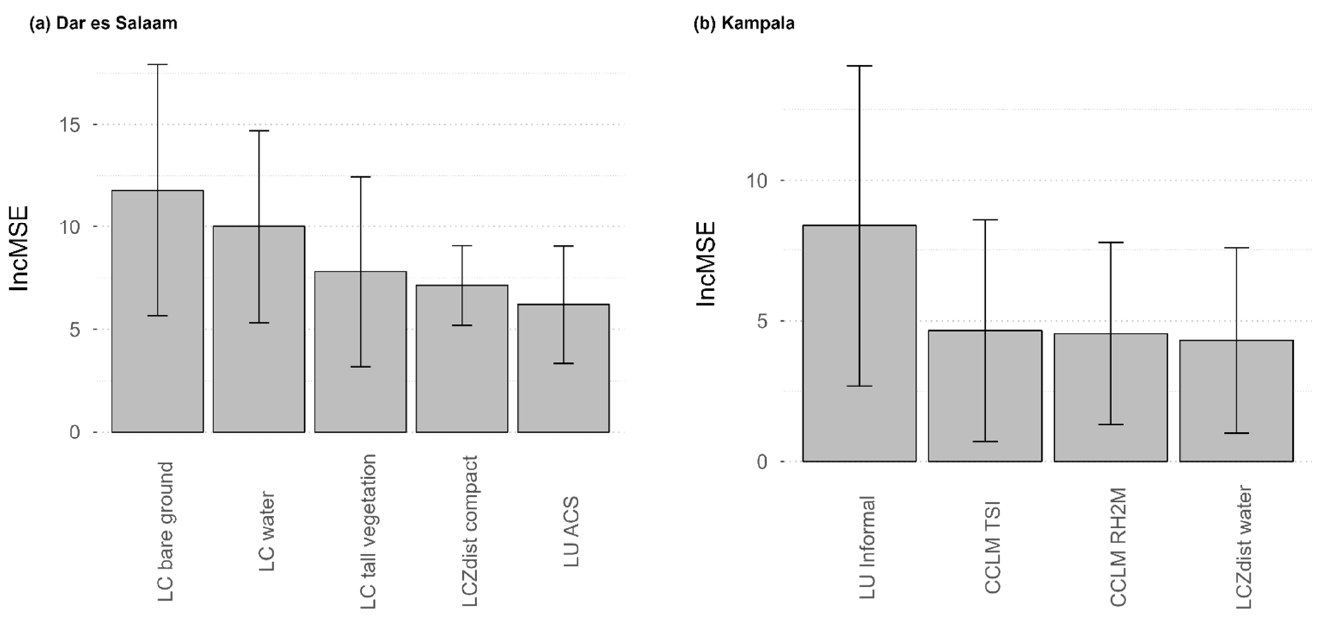
Figure 2. Covariate importance in the best model (Base + LCZ + CCLM + LULC) for ( a ) Dar es Salaam and ( b ) Kampala. The covariate importance is an average increase in mean squared error (Inc MSE) computed across the 50 models built in spatial cross-validation. The error bars represent the standard deviation computed across these 50 models.